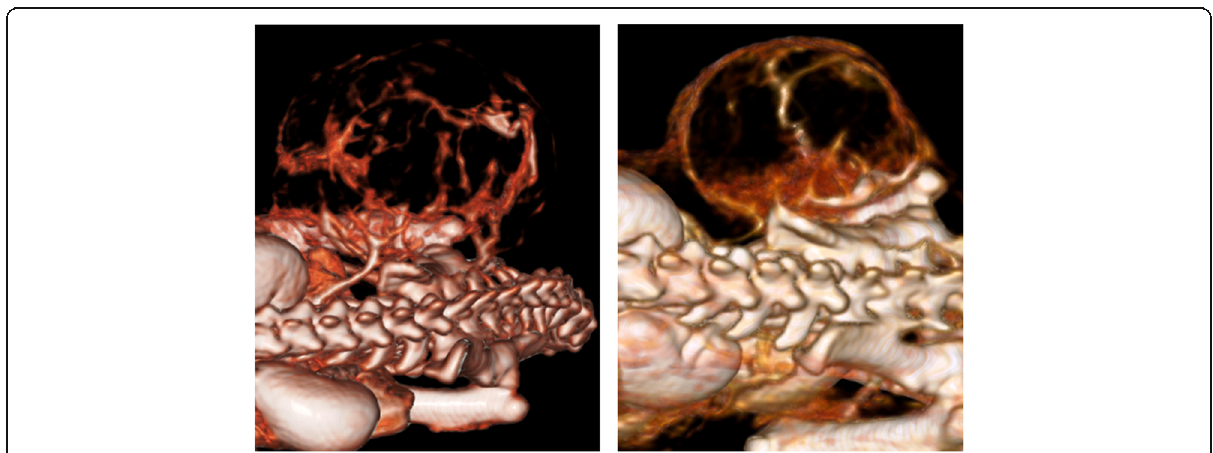
Fig. 7 3d-reconstruction of CT-data. Reconstruction of contrast-enhanced data of two tumors of the co-transplantation group. A vessel originating from the paravertebral region (iliac artery) and supplying the tumor region and vessels within the tumors are clearly